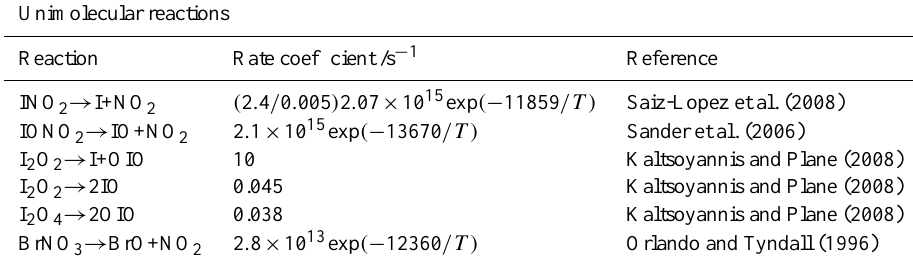
Table A1. Halogen chemistry reaction scheme – unimolecular